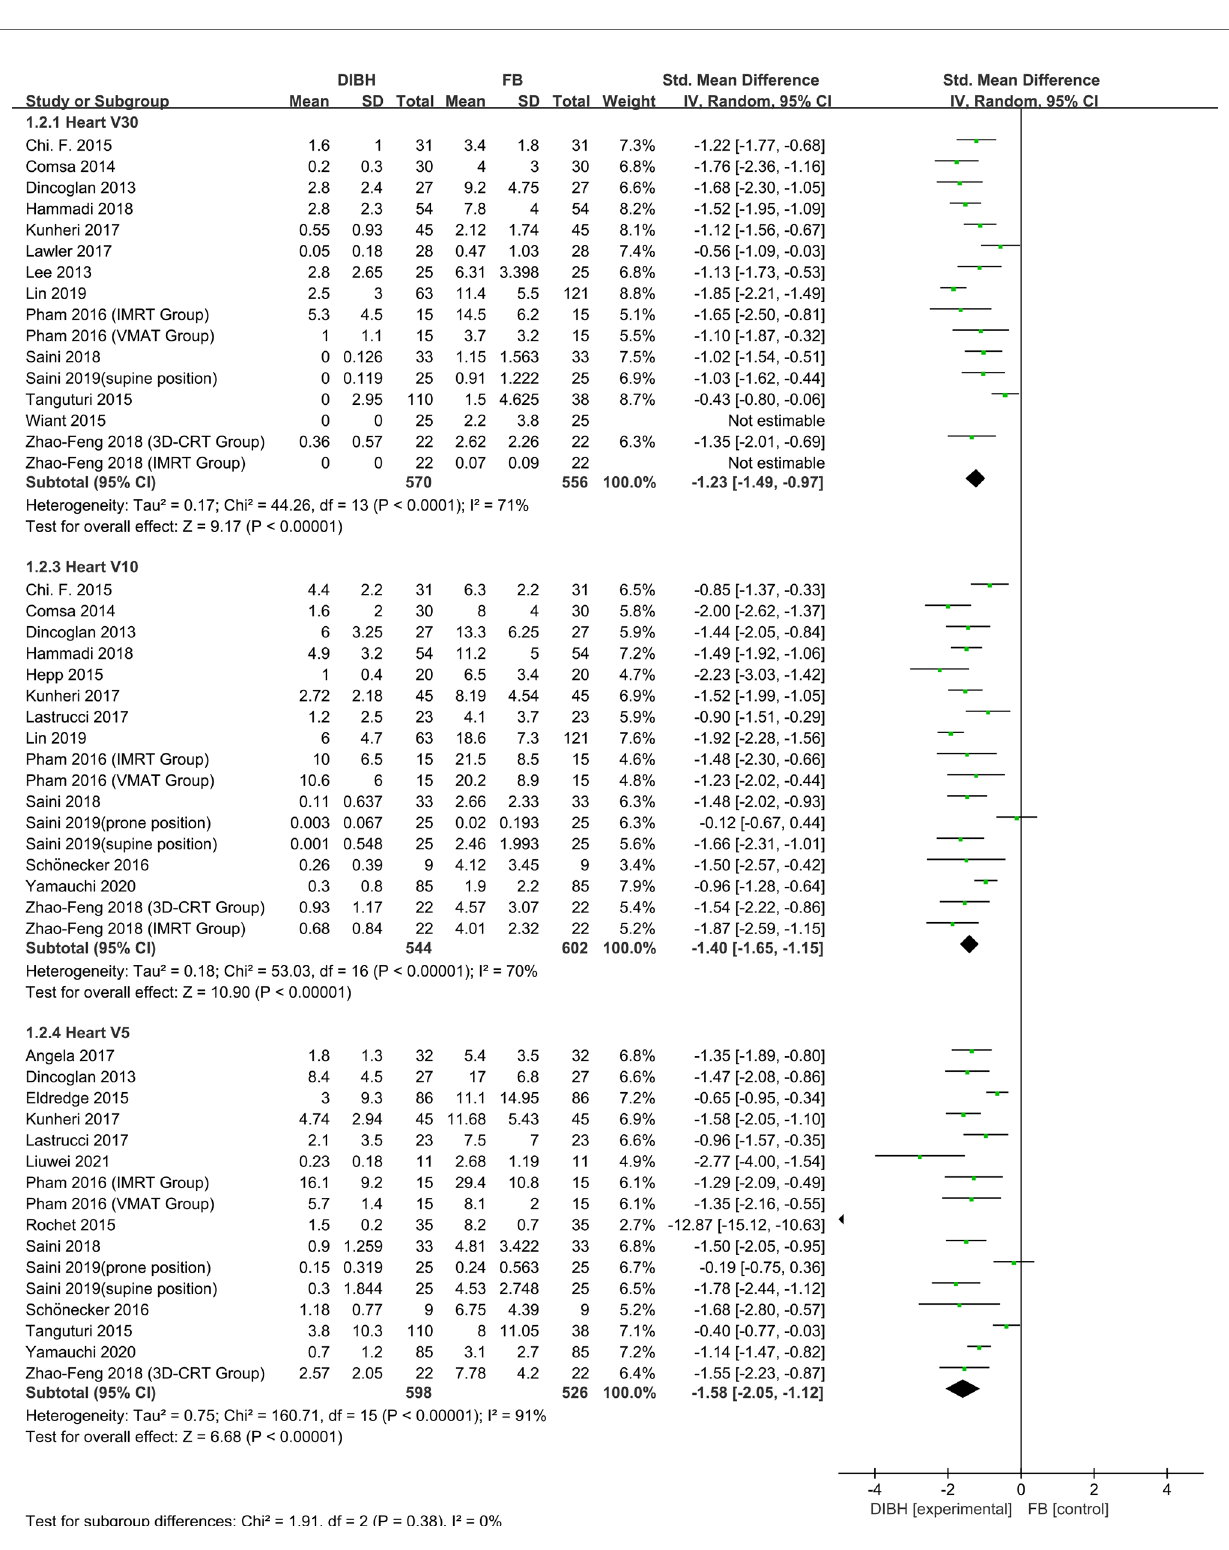
FIGURE 3 | Forest plot of heart dose (V30, V10 and V5) between the DIBH group and FB